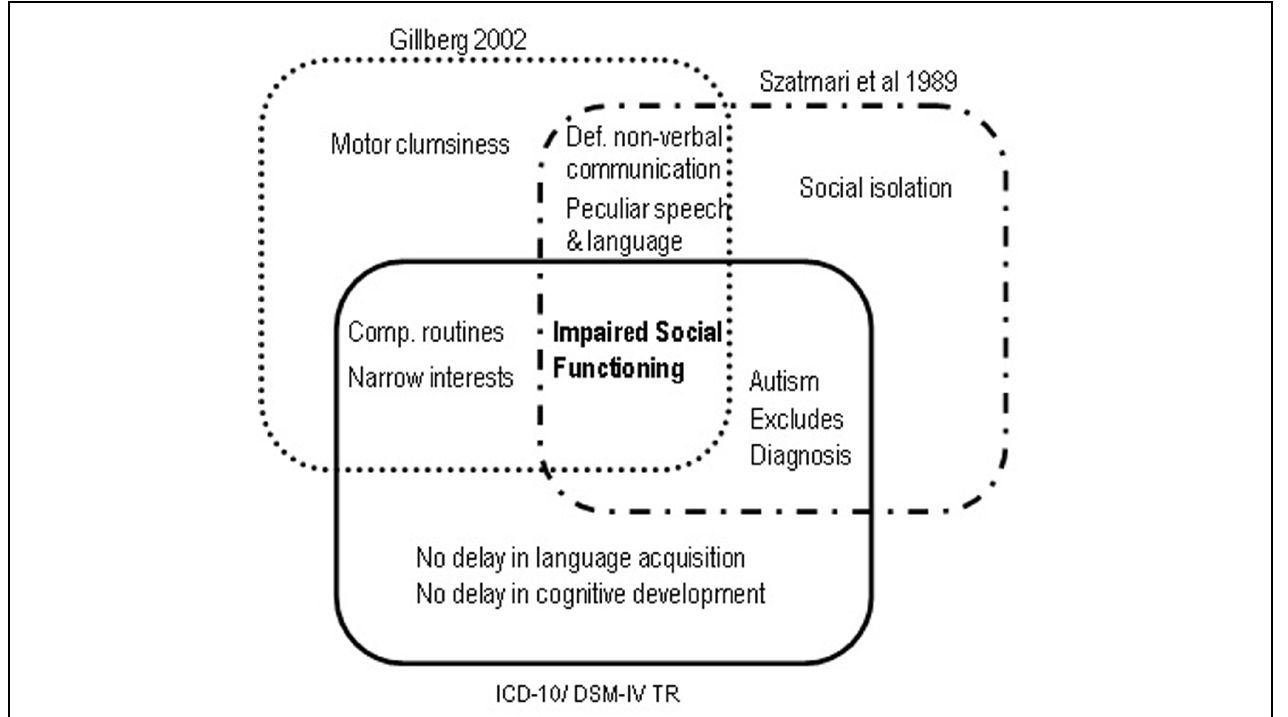
FIGURE 2 | Mandatory diagnostic criteria for Asperger Syndrome according to Szatmari et al. (1989), Gillberg (2002), ICD-10 and DSM-IV